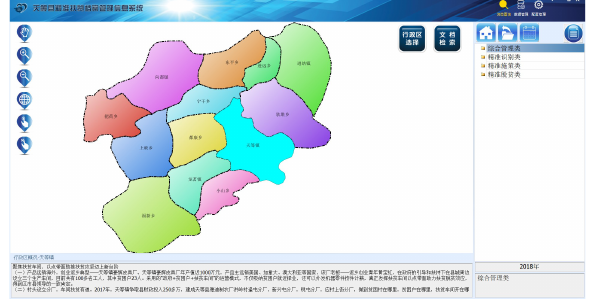
Figure 4. Archives Desktop-client system